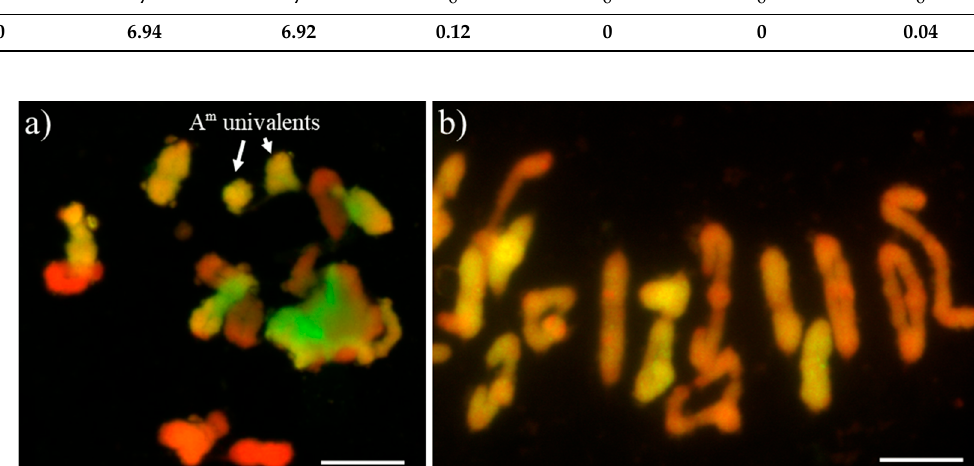
Figure 4. Chromosomes of tetraploid triticale at metaphase I of meiosis of pollen mother cells (PMCs) originated from ( a ) S 2 generation plant; and ( b ) S 3 generation plant. A-genome chromosomes were labelled using digoxigenin-11-dUTP (green) and R-genome chromosomes were labelled with tetra ‐ methyl 5dUTP ‐ rhodamine (red). Scale bars = 5 μ m.